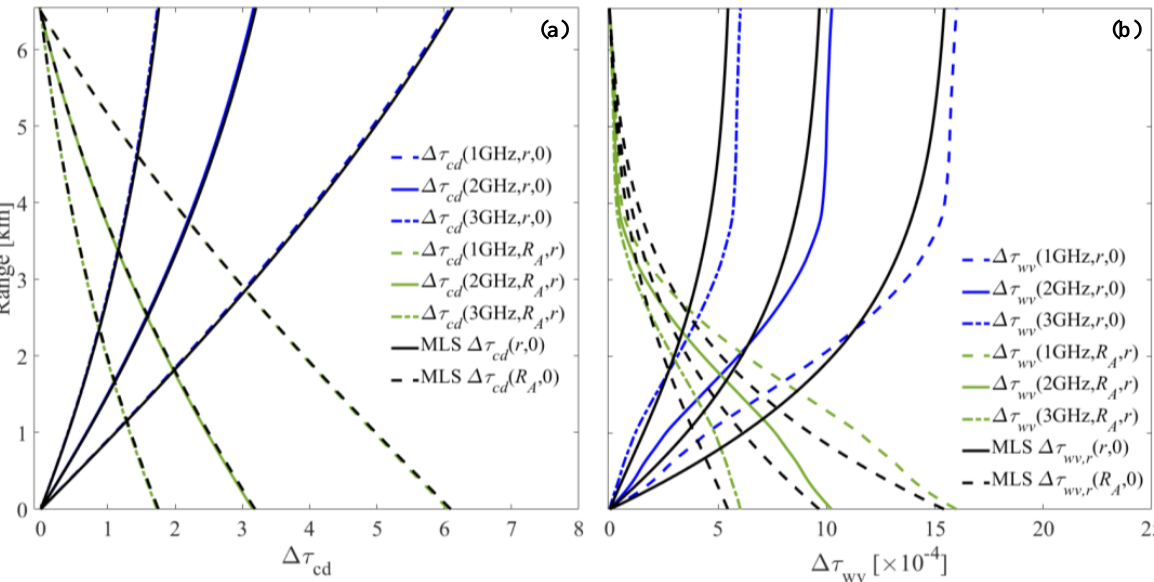
Figure 9. Modeling of the 2-μm IPDA lidar double-path differential optical depth for ( a ) measured CO 2 , Δ τ cd , and ( b ) interfering H 2 O, Δ τ wv assuming perfect nadir operation. Results obtained using MGD (colored curves) and MLS model (black curves), presented in Figure 8 using on-line wavelengths of 1, 2 and 3 GHz. Range represents variable flight altitude for constant sea-level elevation (blue curves) and variable ground elevation for a constant flight altitude of 6.5 km (green curves).